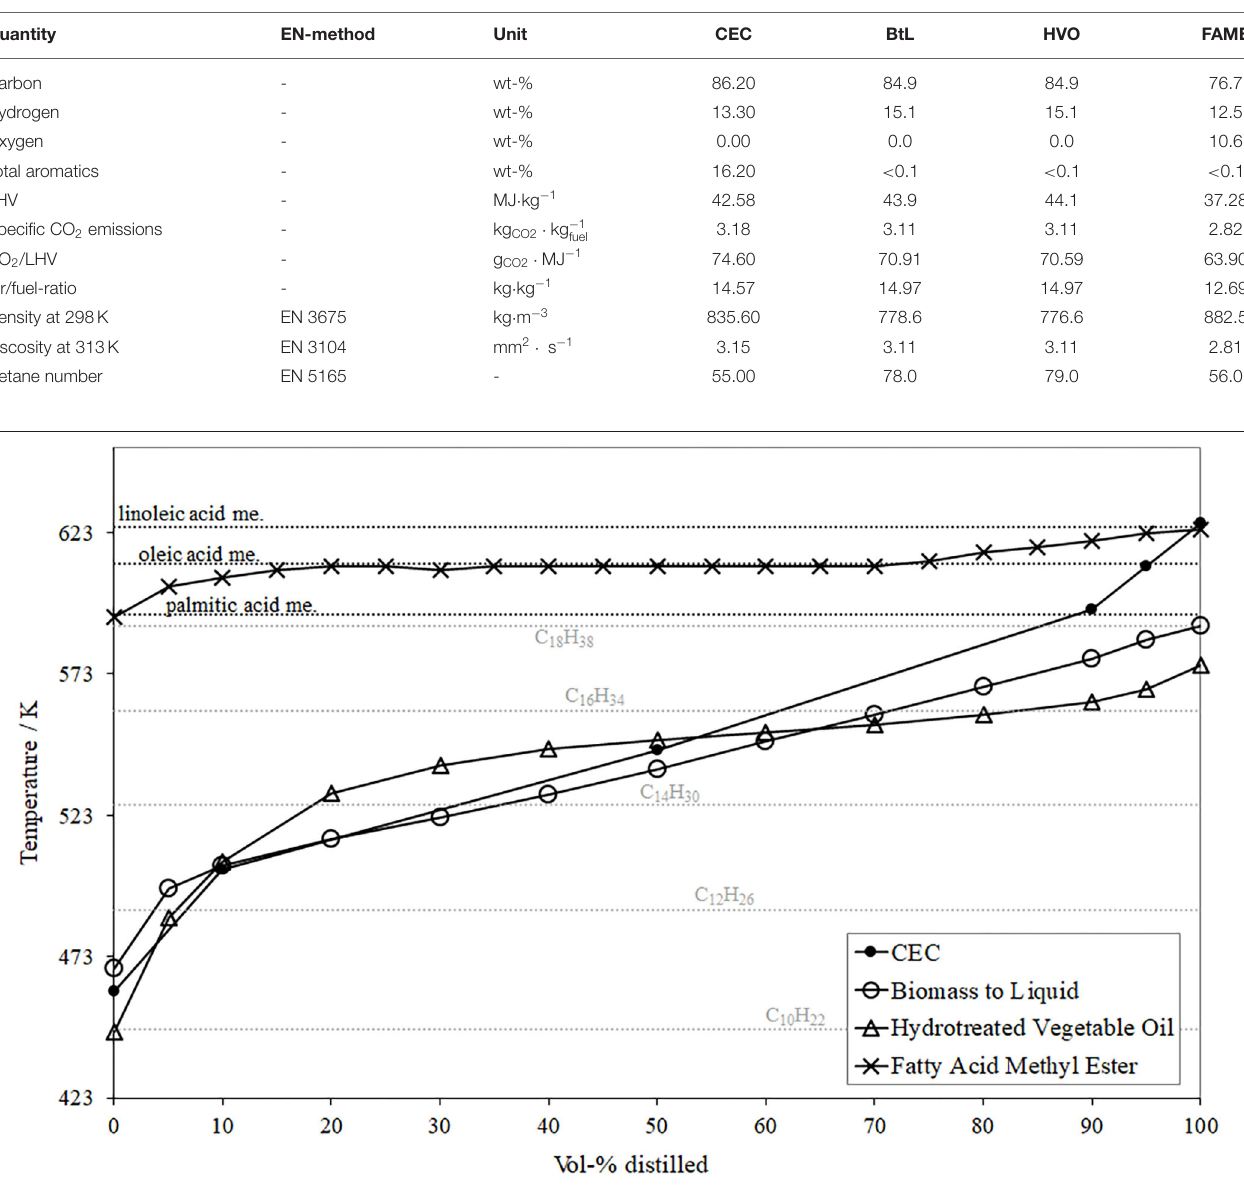
FIGURE 4 | Distillation curves of the basic fuels prior blending (Moeltner et al.,